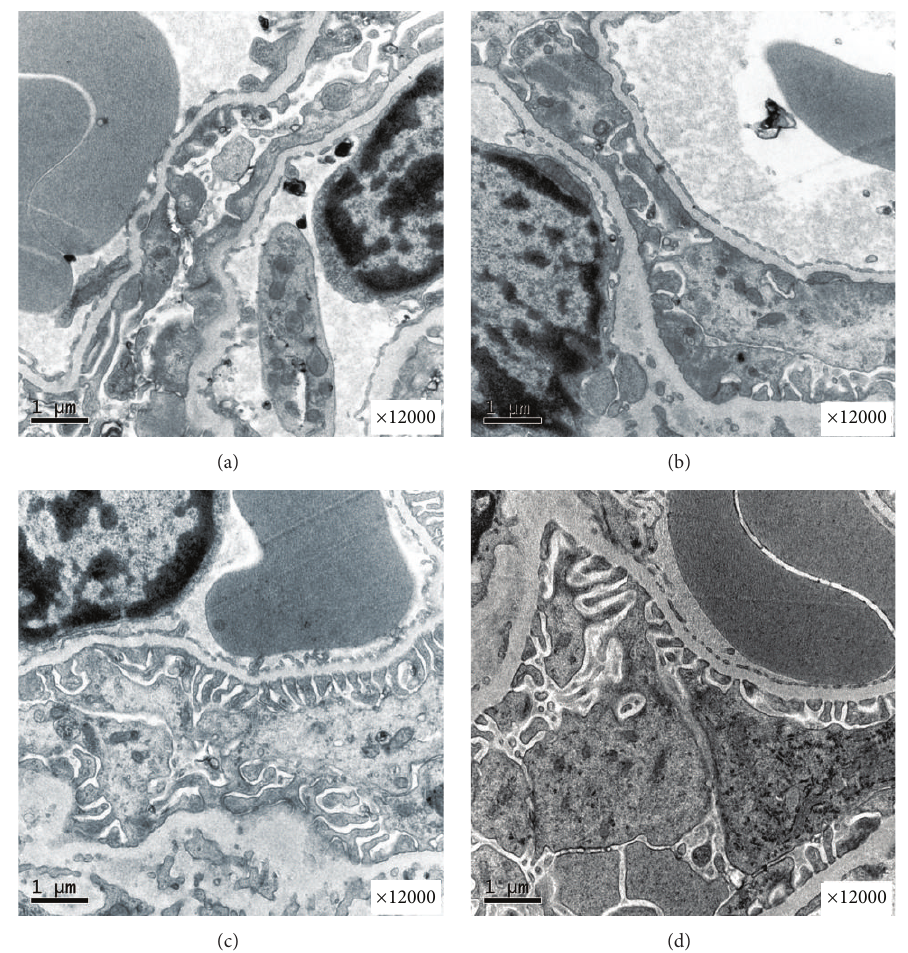
Figure 3: Electron microscopy. Irregular thickening of the GBM and the fusion of podocytes were observed in the DN group (a) and the SR group (b) by electron microscope. The fusion of podocytes foot processes was rare, and the thickening of the GBM was alleviated in the MIT group (c) and the Com group